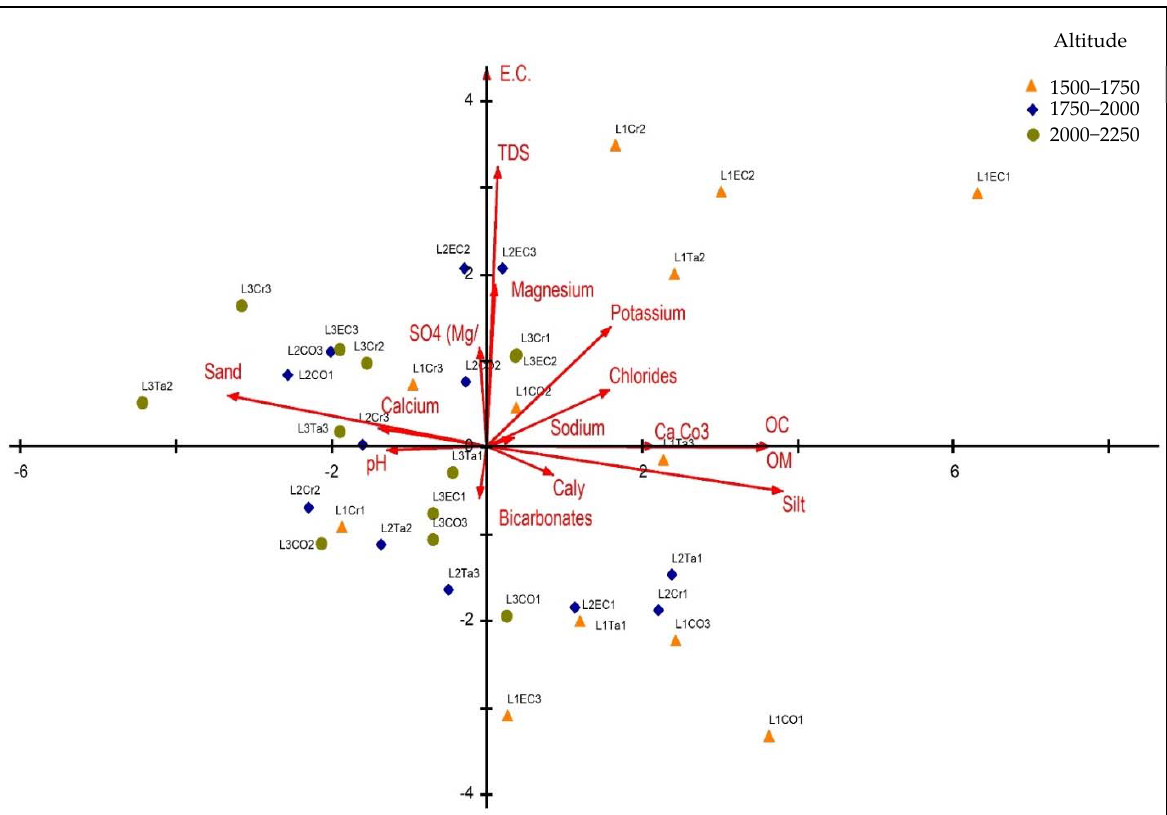
Figure 3. PCA joint plot showing target species at different altitudes in relation to soil parameters. Abbreviations: L1 = altitude 1; L2 = altitude 2; L3 = altitude 3; Co . = Cotineaster orbicularis ; Cr. = Crataegus sinaica; Ec. = Echinops spinossissmus; Ta. = Tanacetum sinaicum.